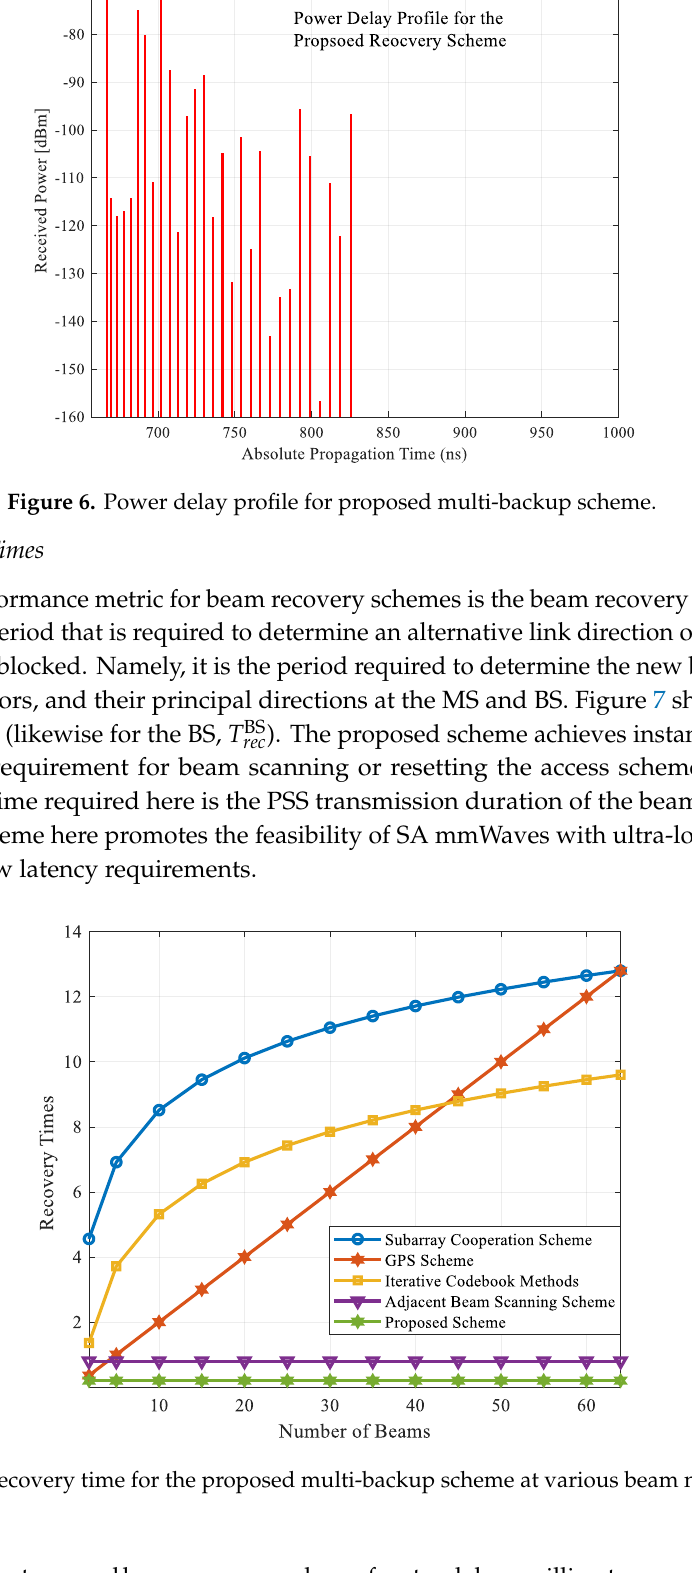
Figure 7. Recovery time for the proposed multi-backup scheme at various beam numbers.